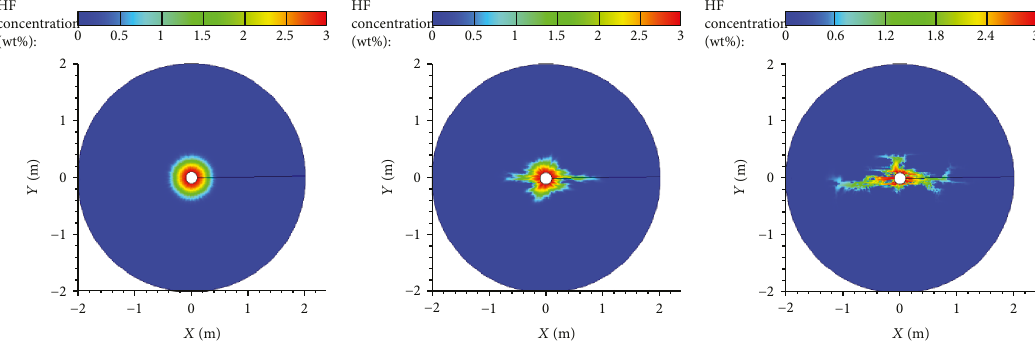
Figure 19: HF distribution after acidizing in two layers.